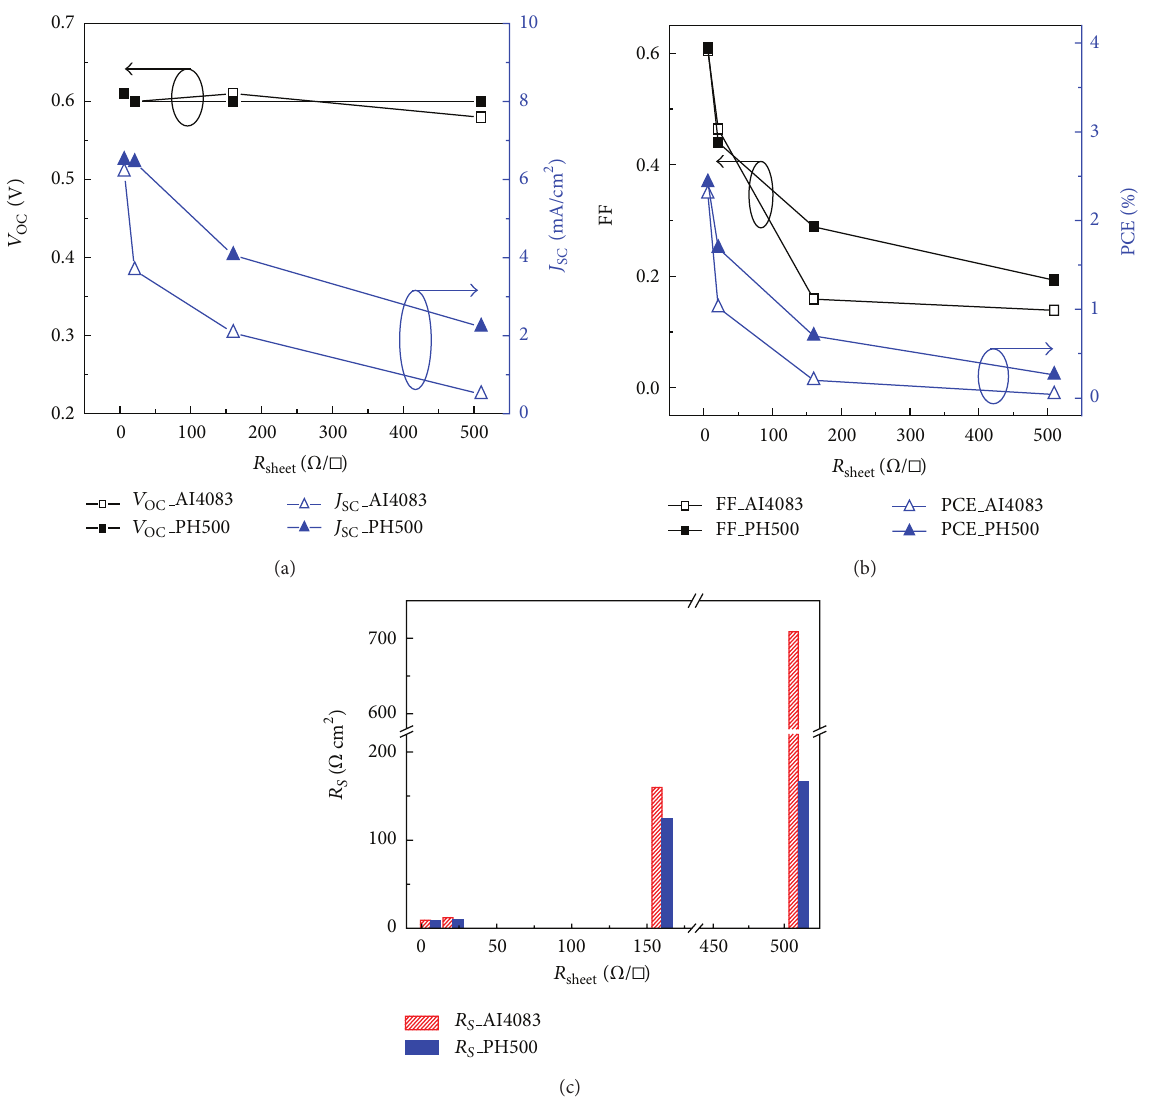
Figure 4: (a) Open-circuit voltage ( 𝑉 ) and short-circuit current density ( 𝐽 OC ) of the ITO electrode on the of the sheet resistance ( 𝑅 sheet